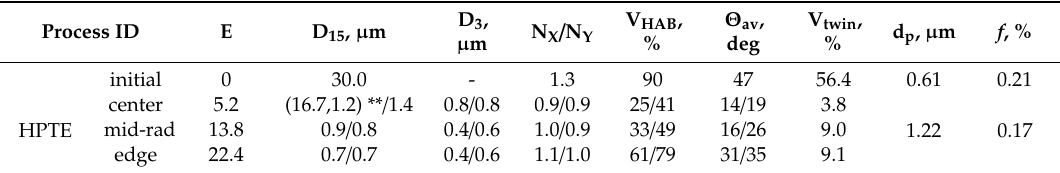
Table 1. Structure parameters of CP Cu rod after the HPTE treatment, based on the SEM–EBSD and BSE imaging